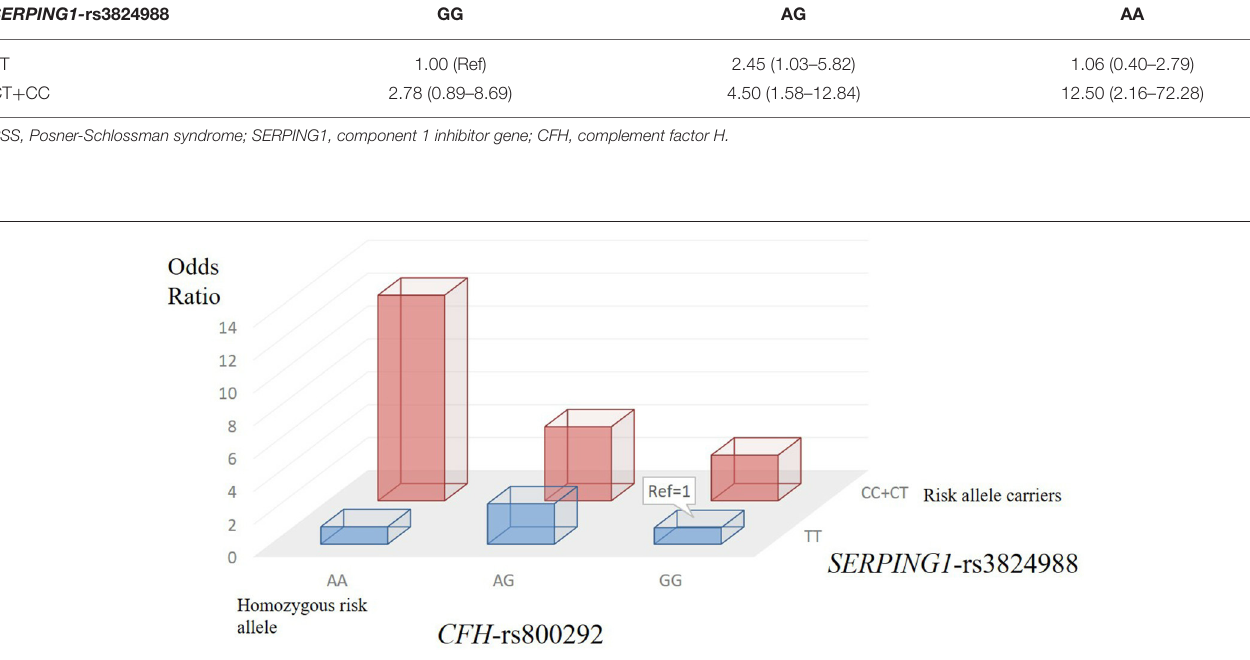
FIGURE 3 | Two-locus ( CFH and SERPING1 ) genotype-specific PSS risk.